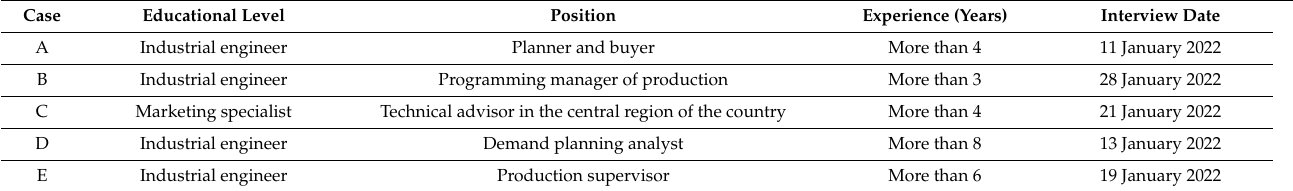
Table 3. Profiles of the